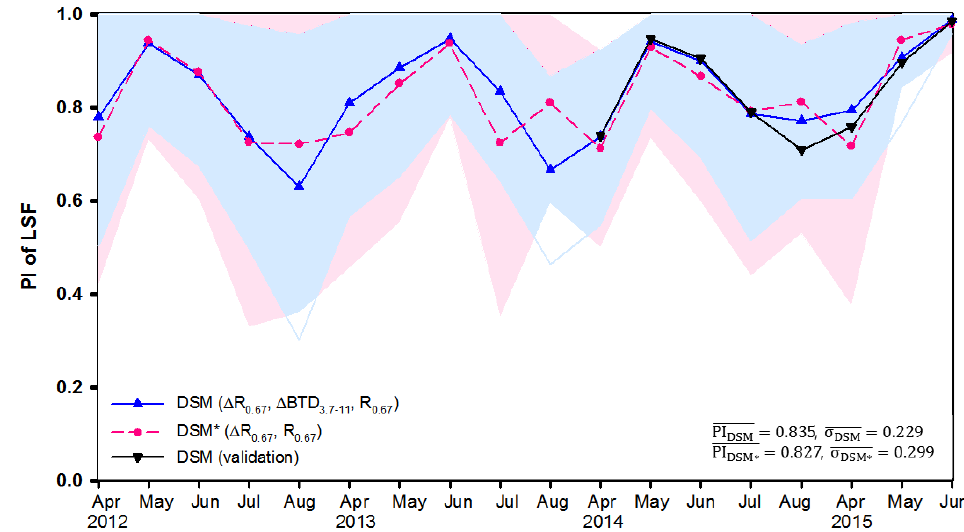
Figure 11. Same as Figure 10 except for DSM PI ( ▲ , blue solid line) and DSM* PI ( ● , pink dashed line) with one standard deviation ( ±1σ) of PI values in a month. The shaded area in blue and pink indicate the standard deviation values of DSM PI and DSM* PI, respectively. The overbars of PI and σ indicate the averages of their 18 monthly values, respectively. In addition, a time series for DSM PI in Period 2 ( ▼ , black solid line) was shown for validation..